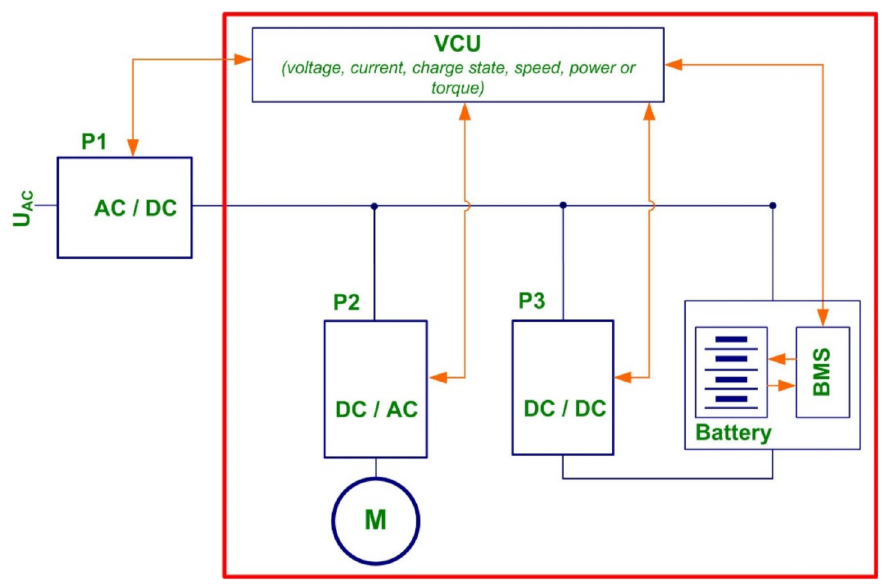
Figure 3. Schematic diagram of the machine power